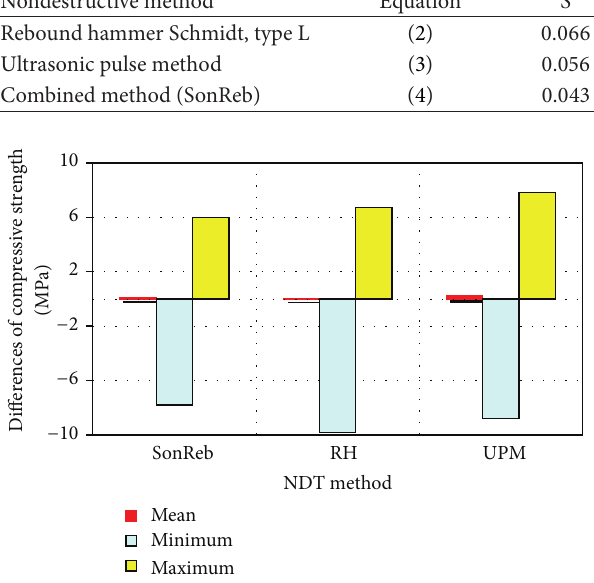
Figure 4: Comparing the differences between the actual compres- sive strength and compressive strength obtained from nondestruc- tive